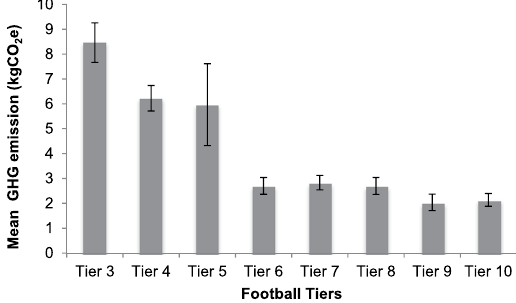
Figure 2. Mean GHG emissions per spectator across eight football tiers (N = 1,406). Error bars denote mean ± standard error of the mean.